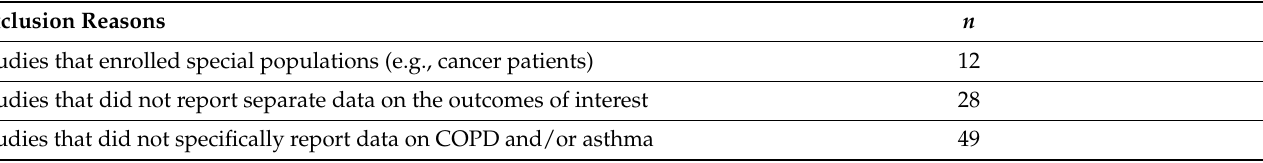
Figure A1. Funnel plots for ( A ) studies included in the COPD analyses; Egger’s test p = 0.139 and ( B ) studies included in the asthma analyses; Egger’s test p = 0.388. Table A1. Full text articles excluded with reasons.